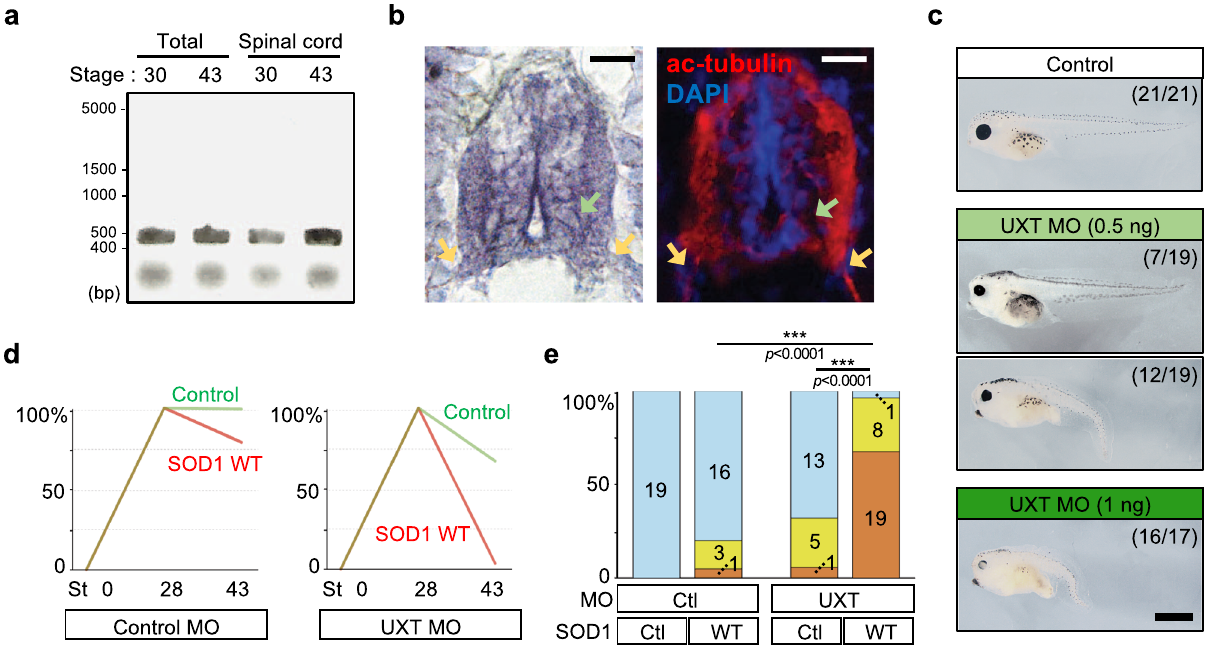
Fig. 8 UXT is required in coping with proteotoxicity in Xenopus. a Reverse transcription-PCR of UXT mRNA in whole tadpole and spinal cord tissue. The entire coding sequence of UXT mRNA was ampli fi ed with a band of 460 bp. b In situ hybridization of UXT mRNA (left) and immunohistochemistry of acetylated tubulin (right). The green arrow indicates a lower motor neuronal cell body and the yellow arrows indicate the axons of these neurons. Scale bar, 10 µ m. c UXT morpholino (MO) was injected to four blastomeres at the eight cells stage. The injected tadpoles showed a dose-dependent defect in gross morphology in contrast to the control group. The numbers indicate the number of embryos with the same morphology as the representative image out of all examined embryos. Scale bar, 1 mm. d Tadpoles injected with 0.5 ng of control or UXT MO together with wild-type SOD1, but showing normal morphology were analyzed for their motor ability as in Fig. 7d. In three independent experiments, each with the full set of groups, the behaviors of 19, 20, 19, and 28 tadpoles were recorded for control, SOD1 WT, UXT MO, and UXT MO + SOD1 WT group, respectively. St stage. e Quanti fi cation of d at stage 43. Cyan, yellow, and orange bars indicate normal, reduced, and no swimming responses, respectively. Ctl control. *** p < 0.001 (two-sided Fisher ’ s exact